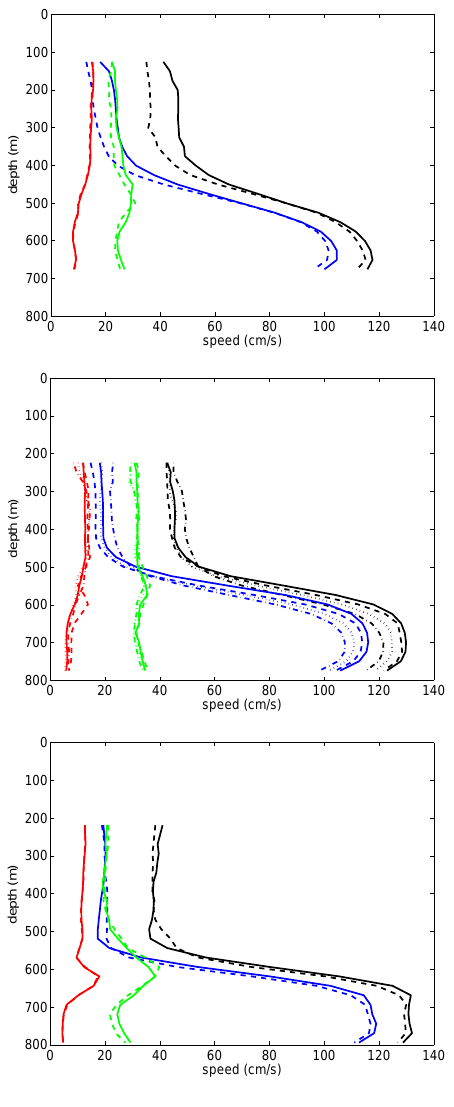
Fig. 8. Vertical profiles of 3 months averaged daily maximum speed for total currents (black), mean residual flow (blue), surge com- ponent (green) and tide (red) at locations FA, FB and FC from top to bottom. Continuous (–) line stands for average over June- September, dashed (- -) line stands for average over September– December, dotted (...) line stands for average over December– March and dash-dotted (-.-.) line stands for average over March– June, only for location FB (mid plot). Instead continuous line stands for monthly averaged daily maxima over July–August and dashed line stands for monthly averaged daily maxima over August- September for locations FA and FC (top and bottom plots) where only 71 days long time series are available.